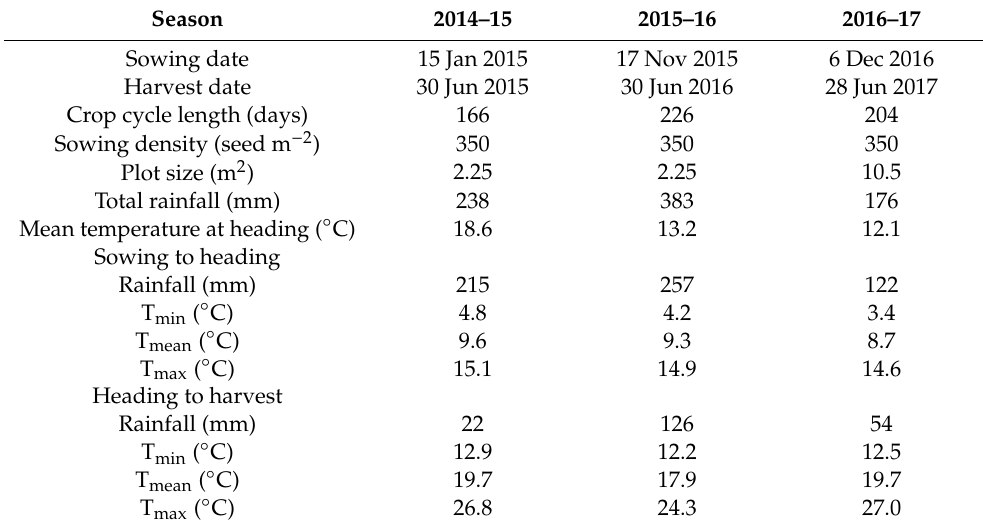
Table 2. Description of experimental seasons analysed in the present